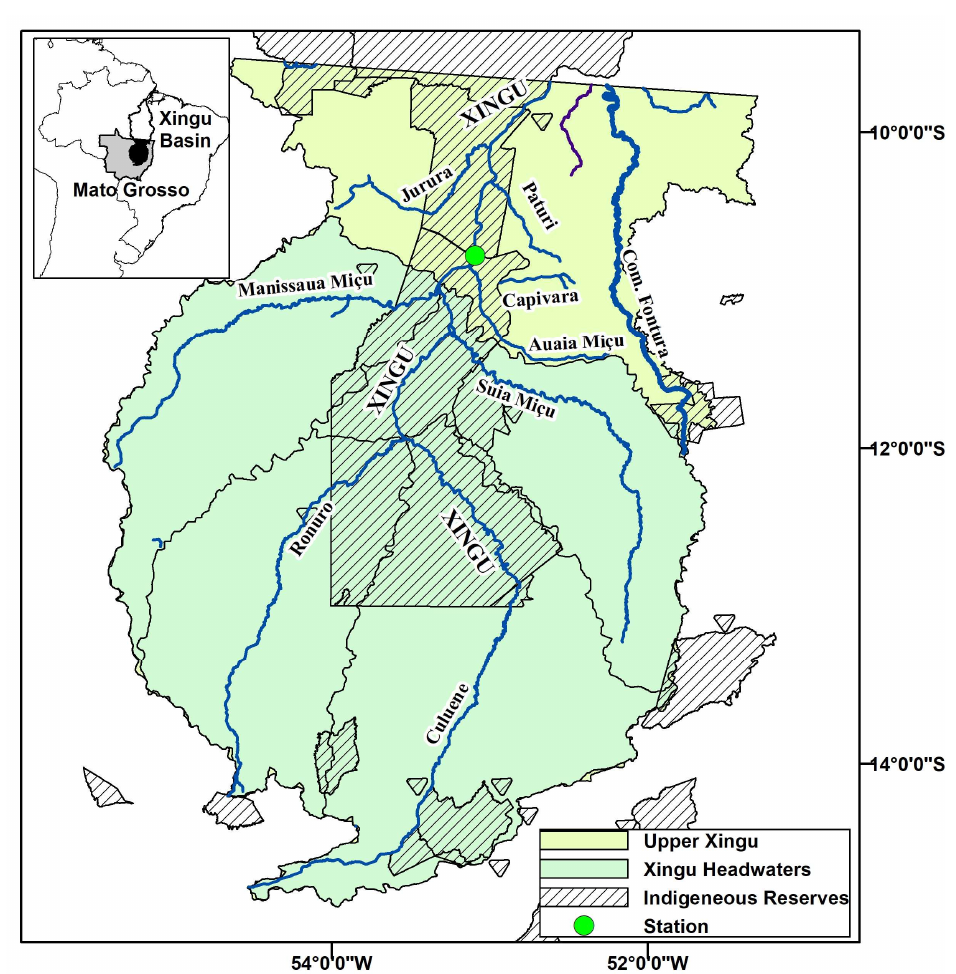
Figure 1. The Xingu Basin of Mato Grosso (XBMT) and its sub-basins: the Upper Xingu Basin (yellow) and the Xingu Headwaters (green) with the main rivers and the location of the discharge measurement station used for validation [30]. The inset shows the position of XBMT (black) in relation to the Xingu River Basin (black outline) and the state of Mato Grosso (grey).